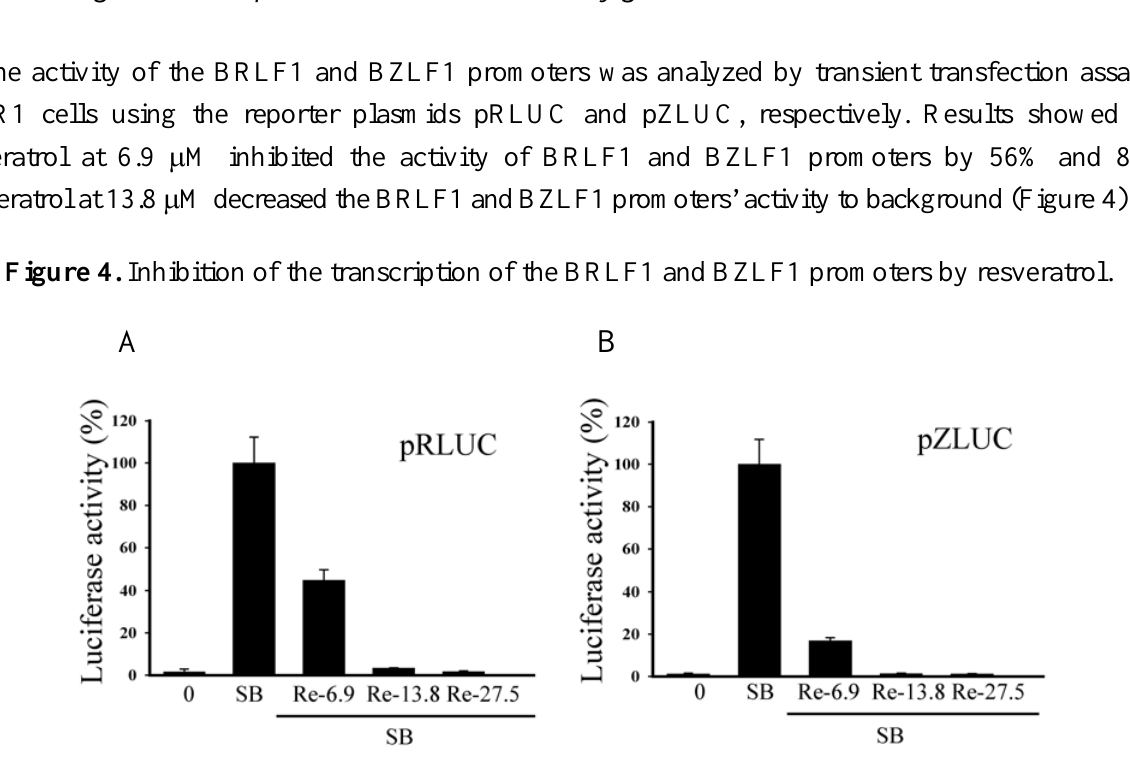
P3HR1 cells were transfected with pRLUC (A) or pZLUC (B) and treated with resveratrol (Re)